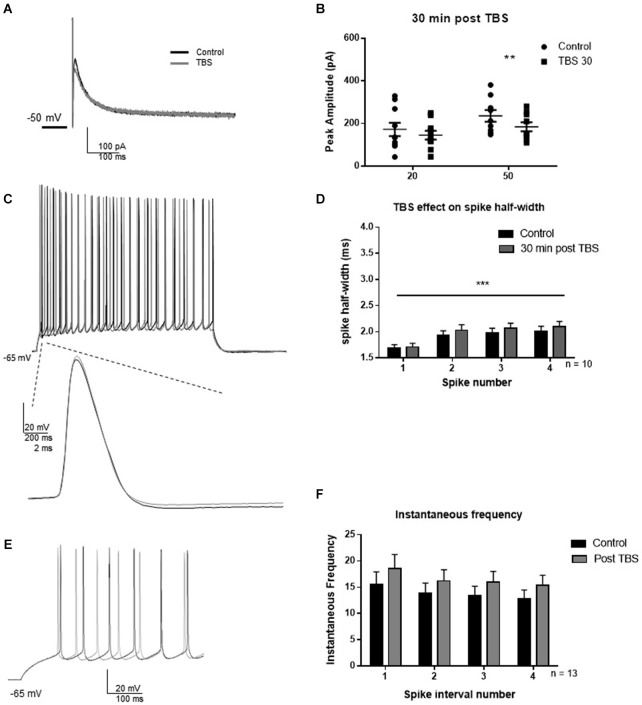
TBS significantly reduced IAHP amplitude, but not spike half-width and spike frequency 30 min after TBS. (A) Example IAHP tail current recorded after depolarization in control (black) and 30 min after TBS (gray). (B) Summary scatter plot of the peak amplitude of the IAHP recorded at 20 and 50 ms depolarizations in control (closed circles) and 30 min after TBS (closed squares). TBS significantly reduced peak IAHP at 50 ms (**p < 0.01). (C) Example of response to 100 pA depolarization in control (black) and after 30 min TBS (gray). Inset—example of a single action potential recorded in control (black) and 30 min after TBS (gray). (D) Summary bar graph of the half-width of the first four spikes in a spike train. TBS did not significantly affect spike half-width 30 min post-potentiation compared to control (white). Significant spike widening was observed across the first four spikes (***p < 0.0001). Data are reported as mean ± SEM. (E) Example of effect of TBS (gray) on the firing frequency in response to 100 pA depolarization compared to control (black). (F) Summary bar graph showing no effect of TBS on instantaneous firing frequency. Data are reported as mean ± SEM.